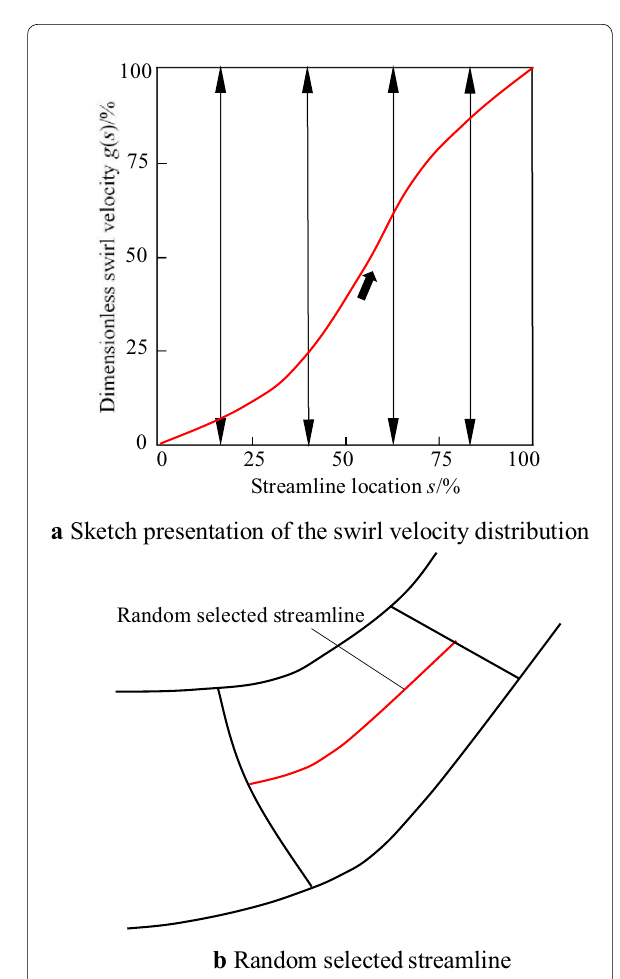
Figure 1 Physical distribution law for the swirl